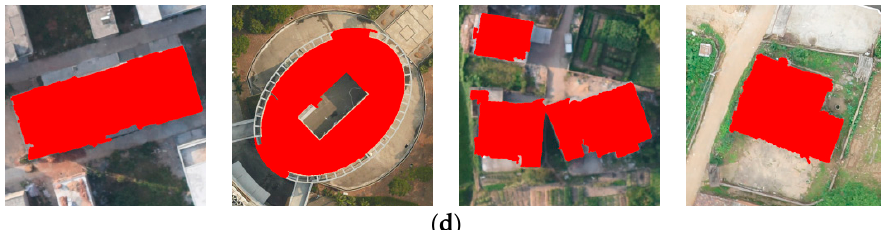
Figure 4. Building extraction using ERS, SEEDS, preSLIC, and LSC algorithms from four building examples corresponding to Figure 2( a ). ( a ), ( b ), ( c ), and ( d ) include the superpixels and the corresponding initial building areas obtained from the ERS, SEEDS, preSLIC, and LSC algorithms, respectively. Table 1. BR and USE values of SLIC, ERS, SEEDS, preSLIC, LSC, and 6D-SLIC in the four images in Figure 2(a).